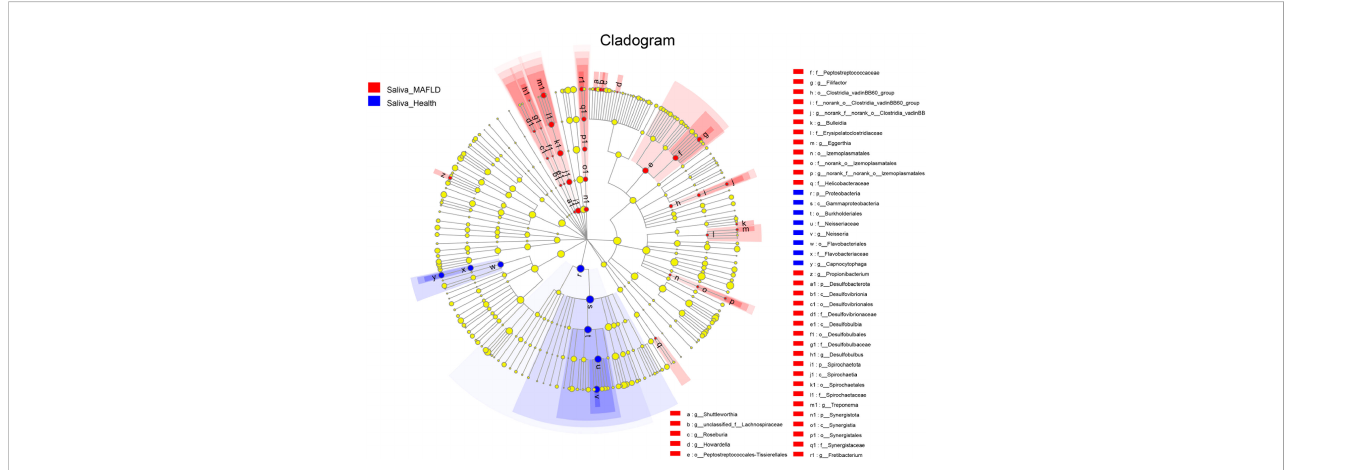
FIGURE 2 Discriminative salivary microbiota with abundance difference in the MAFLD and control groups. A cladogram of taxonomic representation based on LEfSe. Red indicates enrichment in samples from the MAFLD group, and blue indicates the taxa enriched in samples from the control group (LDA>2.0, P